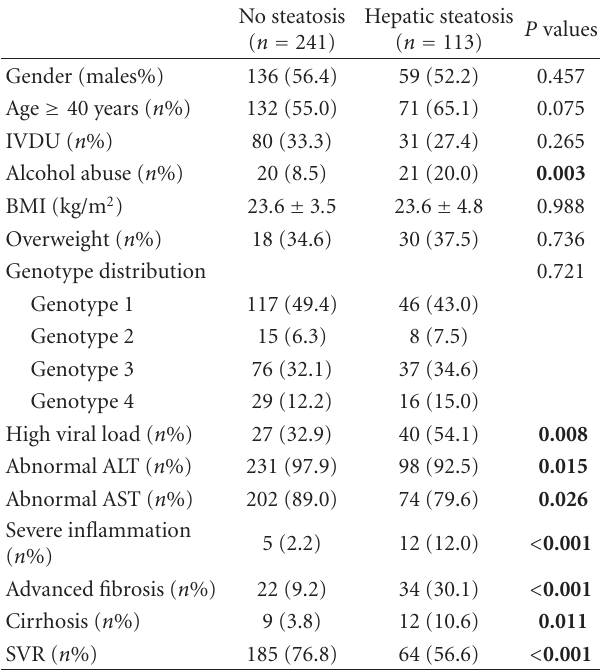
Table 4: Variable associations with presence of hepatic